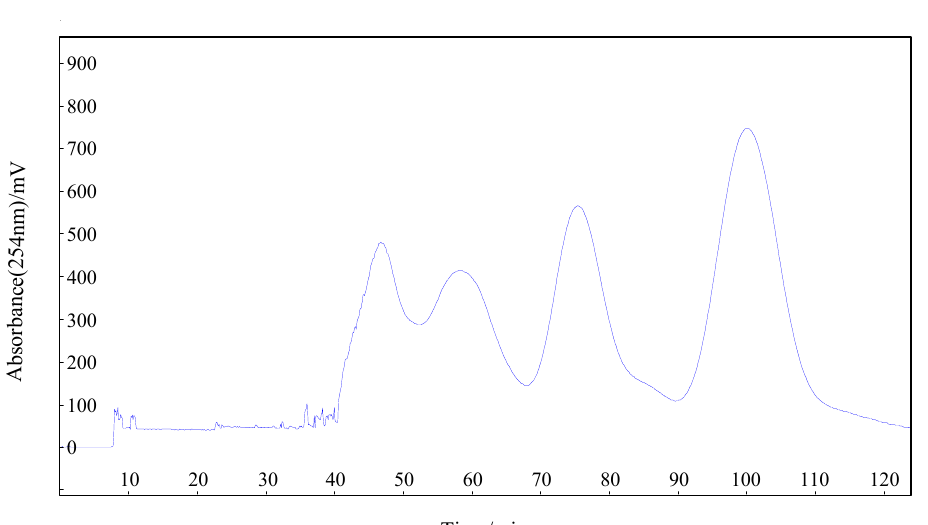
Figure 2. HSCCC separartion of the crude extract ( 1 ) attractant 1 ; ( 2 ) attractant 2 . HSCCC separation conditions: column rotary speed, 800 rpm; column temperature, 25 °C; solvent system, n -hexane-ethyl acetate-methanol-water (1.5:1:1.5:1, v/v/v/v ); mobile phase, lower phase; flow rate, 2 mL/min; detection 254 nm; retention of the stationary phase, 80%; sample injected: 160 mg in 3 mL upper organic phase and 3 mL lower aqueous phase; separation mode: